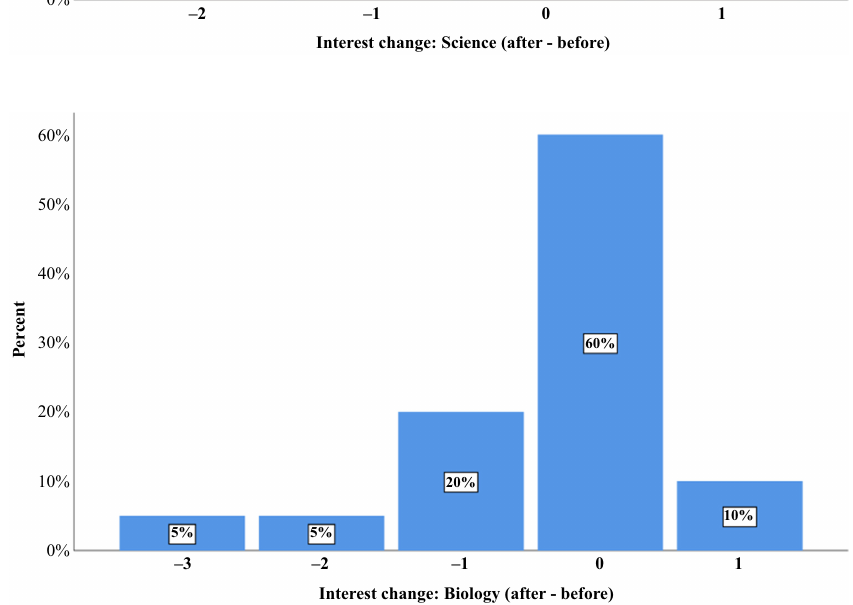
Figure 2. Change in participants ’ interest in science after intervention compared to before intervention